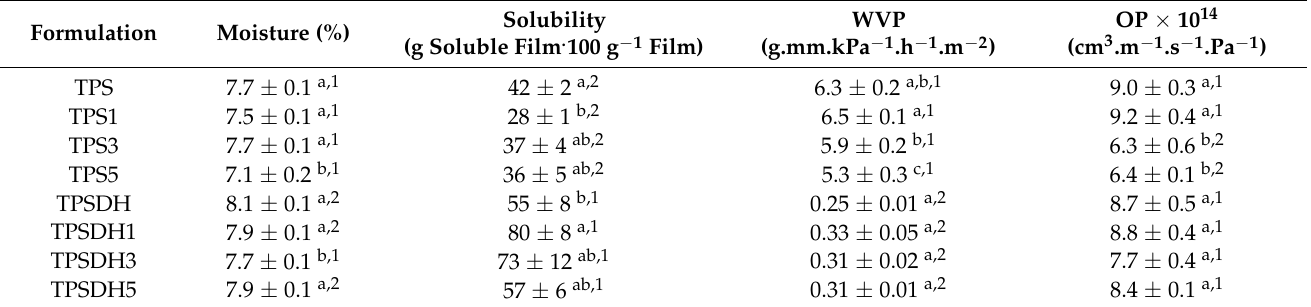
Table 3. Moisture, water solubility, water vapor permeability (WVP), and oxygen permeability (OP) of thermoplastic starch (TPS) and TPS modified by dry heating (TPSDH) films with different contents of cellulose microfibers (CMFs).